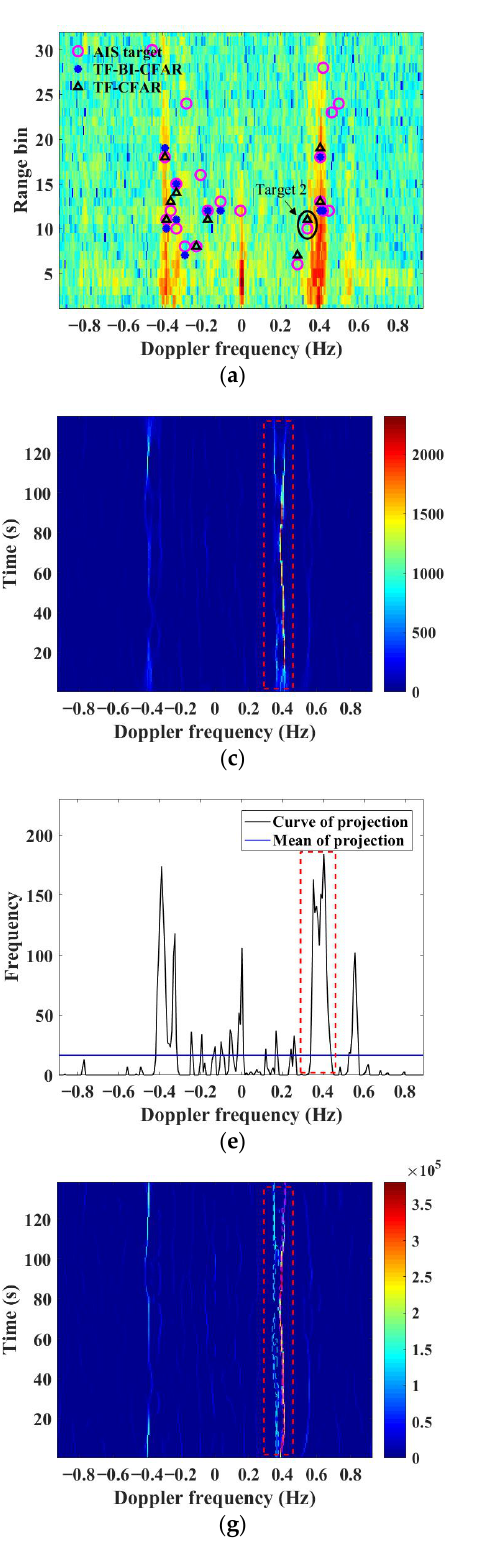
Figure 7. Comparison of clutter edge by TF-BI-CFAR and TF-CFAR at 20:00 on 5 October 2015 and ( c – h ) are from TF-BI-CFAR and TF-CFAR, respectively. ( a ) target matching map on RD; ( b ) power spectrum at the 9th range bin; ( c ) SST image at the 9th range bin; ( d ) binary grayscale image of ( c ); ( e ) vertical projection of ( d ); ( f ) TF ridges extracted from ( c ); ( g ) TF ridges marked by Hessian matrix; ( h ) TF ridges extracted from ( g